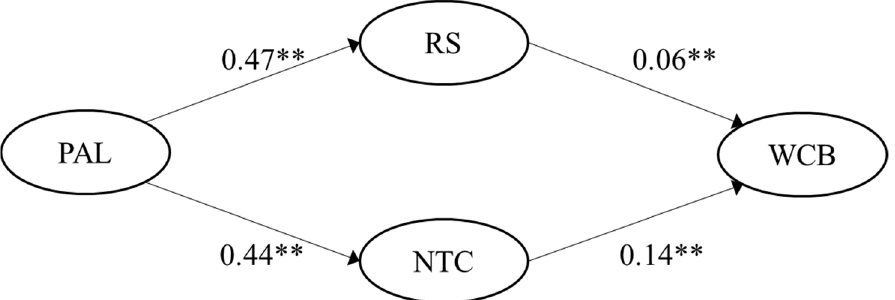
Figure 3. Empirical multiple mediation model for passive-avoidant leadership for the German sample (n = 334). Note: ** indicates a p -value < 0.01; PAL = Passive-avoidant leadership; RS = Role stress; NTC = Negative team climate; WCB = Workplace cyberbullying.